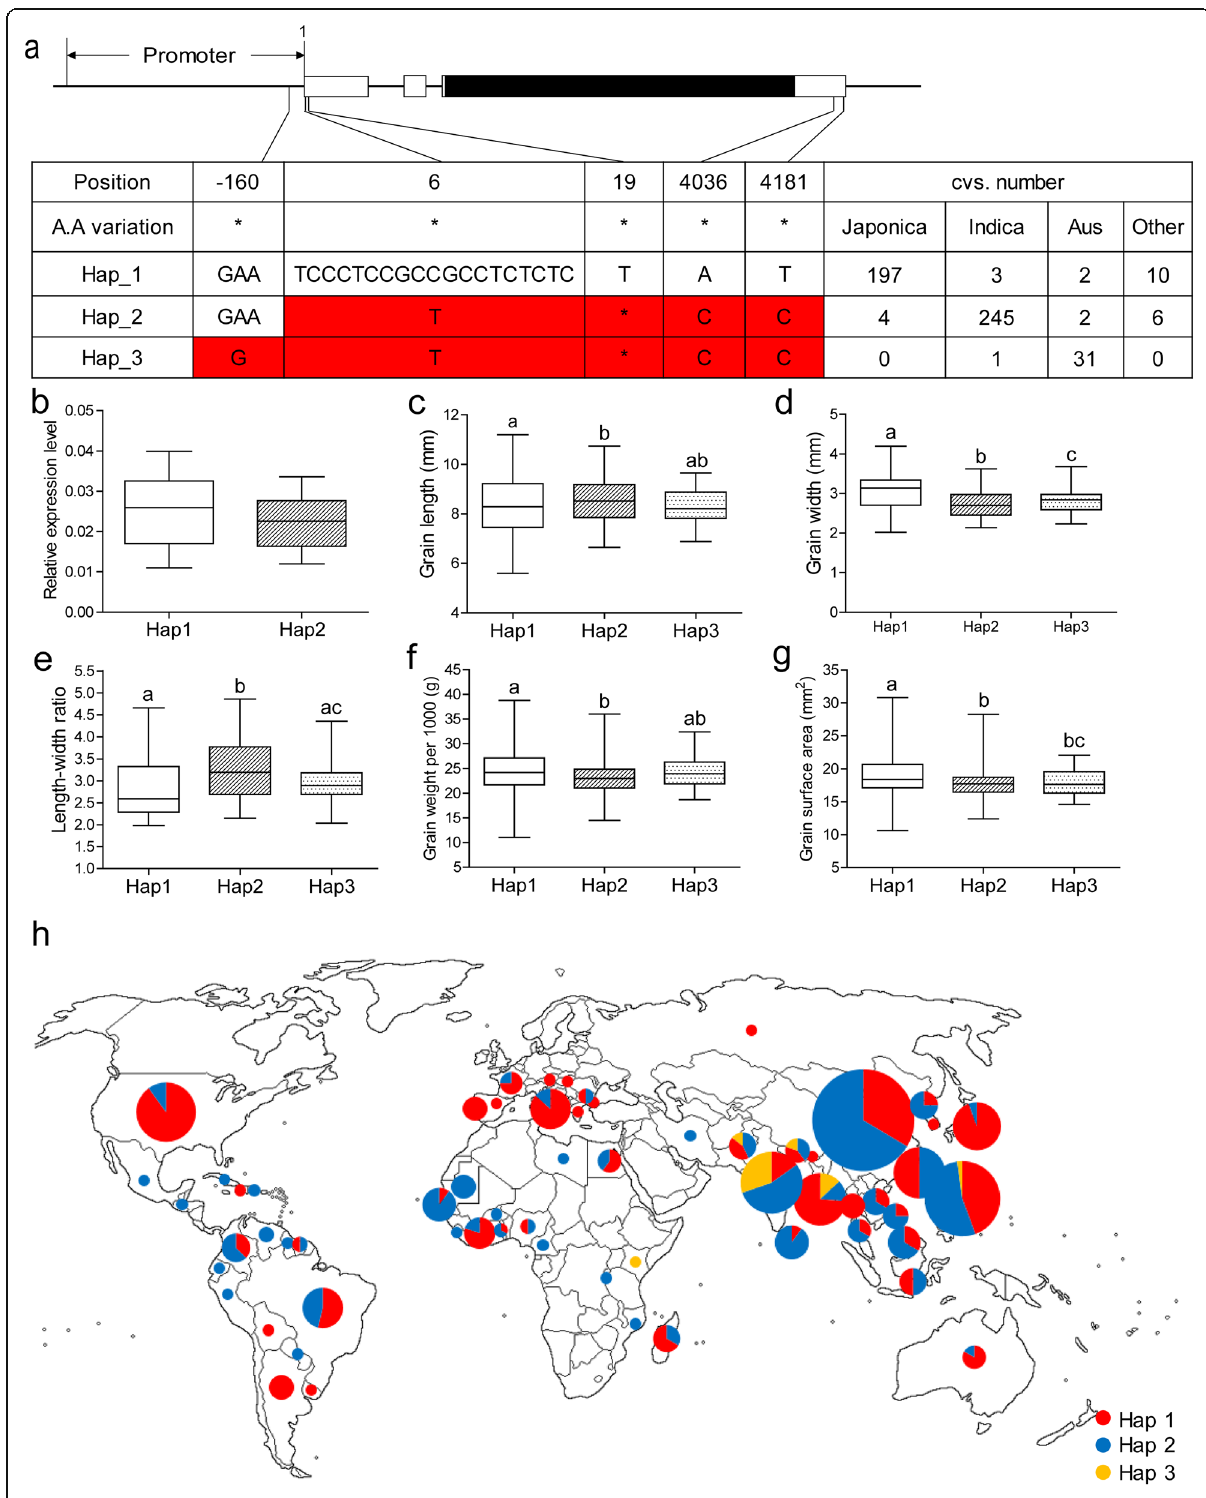
Fig. 9 Haplotype and origin analysis of MIS2 . ( a ) MIS2 gene structure and natural variations among 524 rice accessions. ( b ) Relative expression level of Hap1 and Hap 2 in young panicle. ( c - g ) Comparison of grain length ( c ), grain width ( d ), length-width ratio ( e ), grain weight per 1000 ( f ) and grain surface area ( g ) among accessions containing Hap1, Hap2 and Hap3. The letter on histogram ( a , b and c ) indicate significant differences ( P <0.05) by ANOVA. (H) Geographic origin of accessions containing Hap1, Hap2 and Hap3. Hap1, Hpa2 and Hap3 are represented by red, blue and yellow circles,